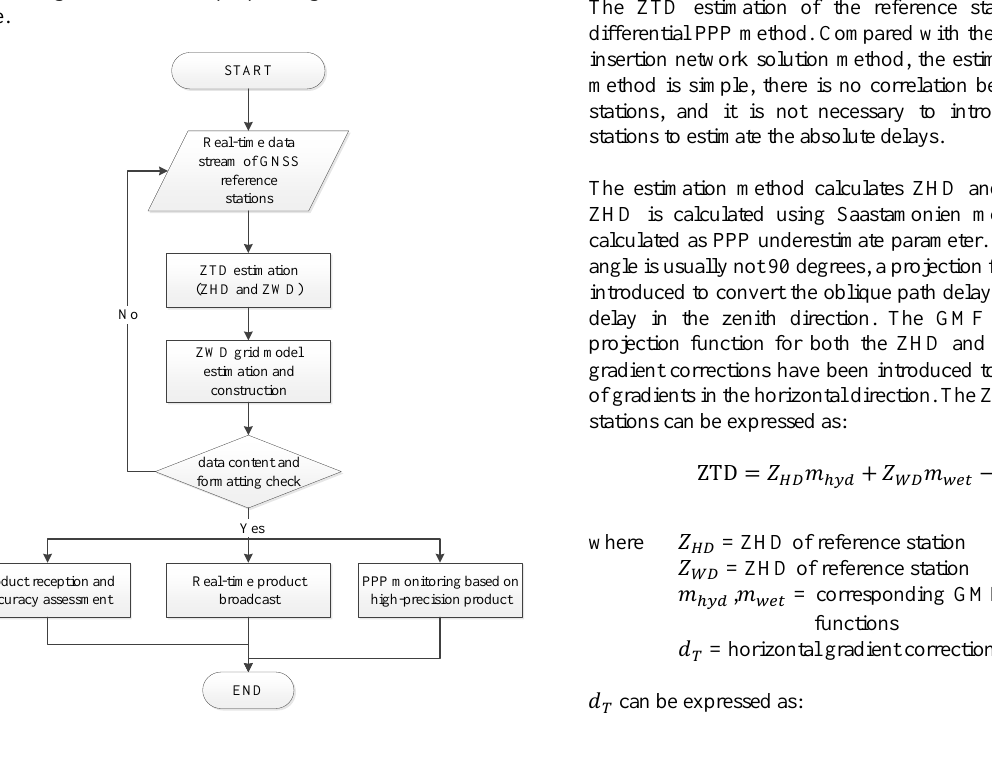
Figure 2. The distribution of Chinese national GNSS reference stations (This figure is a schematic diagram of the topic and does not involve national territory